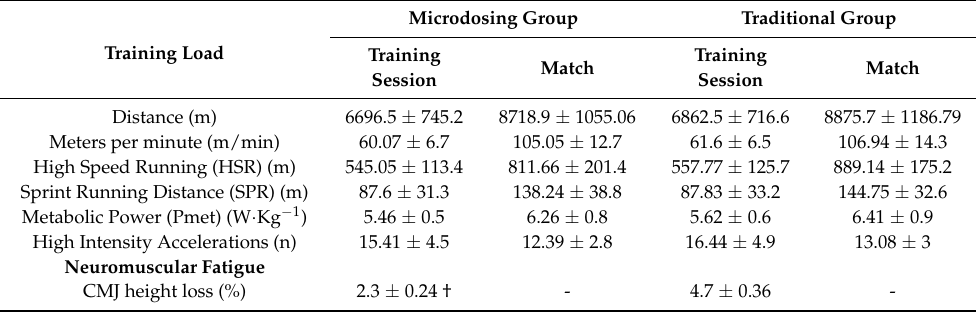
Table 1. Descriptive data of quantified performance variables in matches and training sessions in Field Hockey.